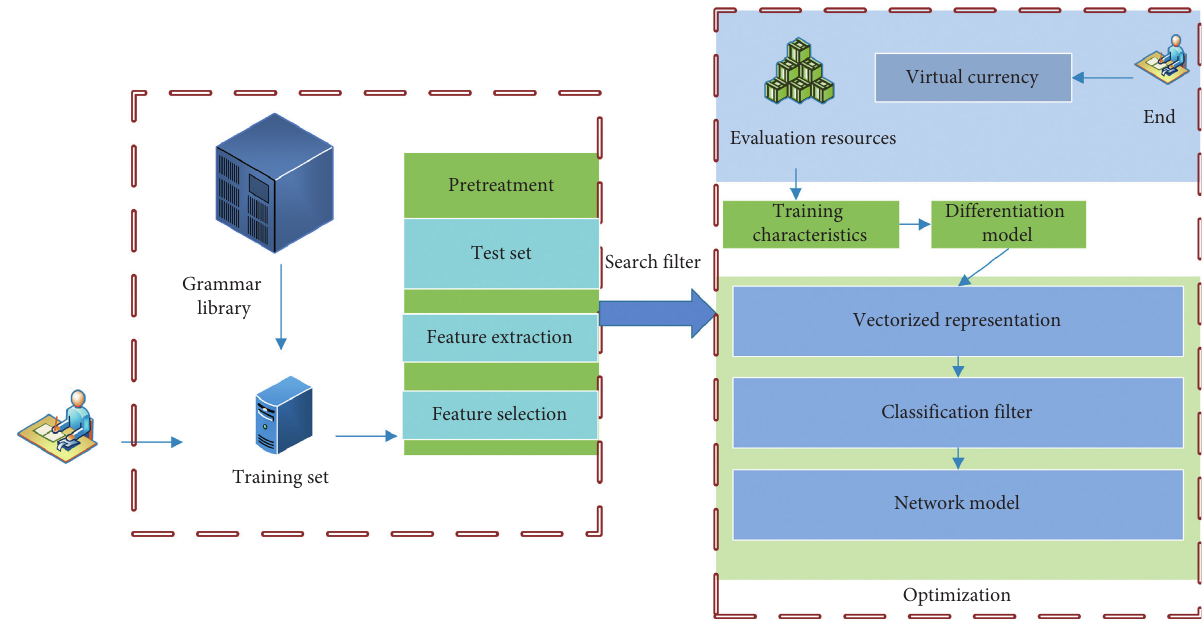
Figure 3: English Grammar discrimination training search